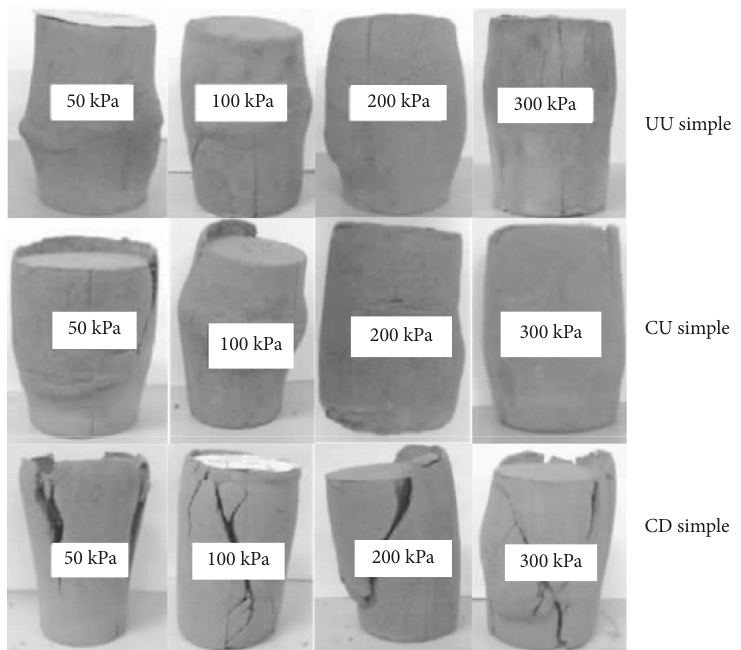
Figure 2: Failure modes of UU, CU, and CD specimens under different confining pressures, from Dong et al.